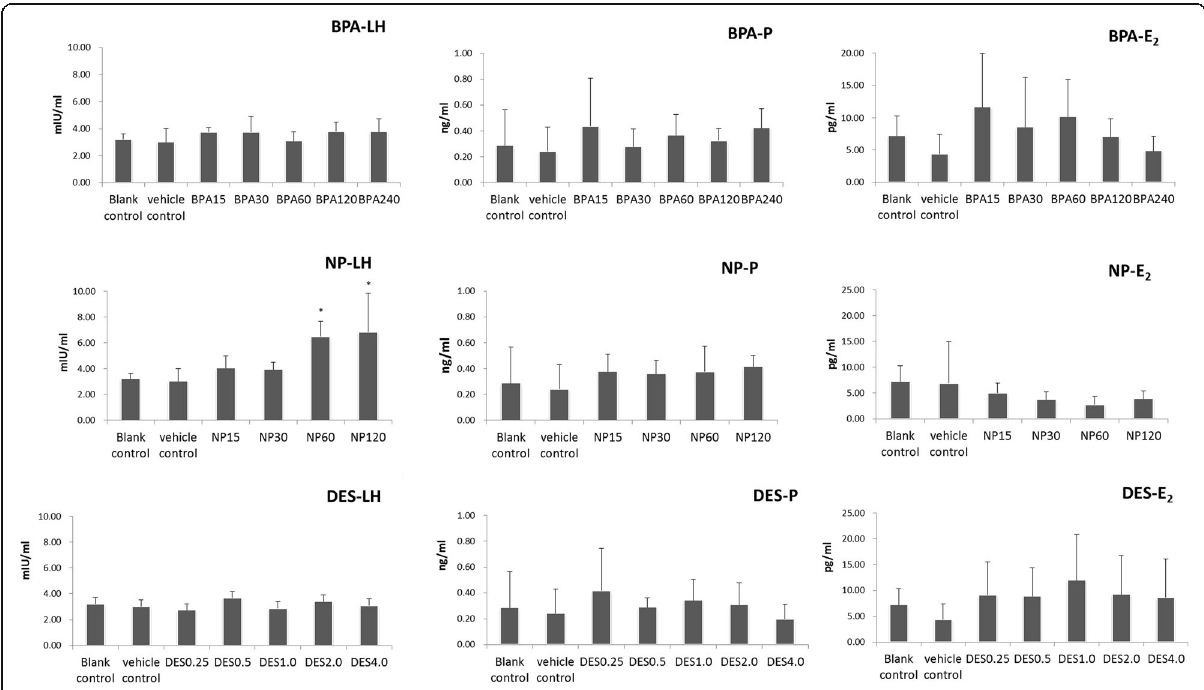
Fig. 3 Effect of BPA, NP, and DES on LH, progesterone, and E2 in immature rats. *: P <